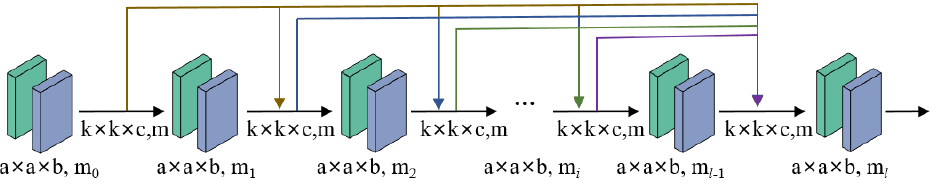
Figure 3. Schematic of the structure of 3D DenseNet.